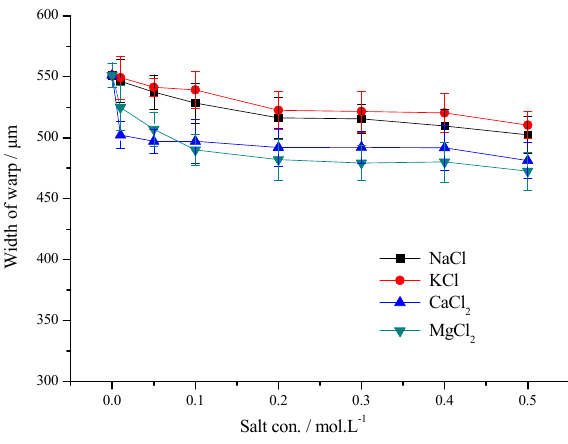
ff ect of salt concentration on the width of warp printing direction. Polymers 2019 , 11 , x FOR PEER REVIEW